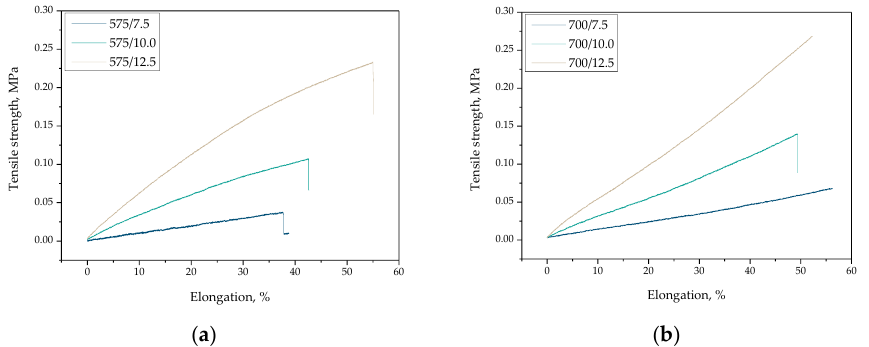
Figure 19. Stress – strain curves of hydrogel samples obtained using various amount of PEGDA 575 ( a ) and PEGDA 700 ( b ).